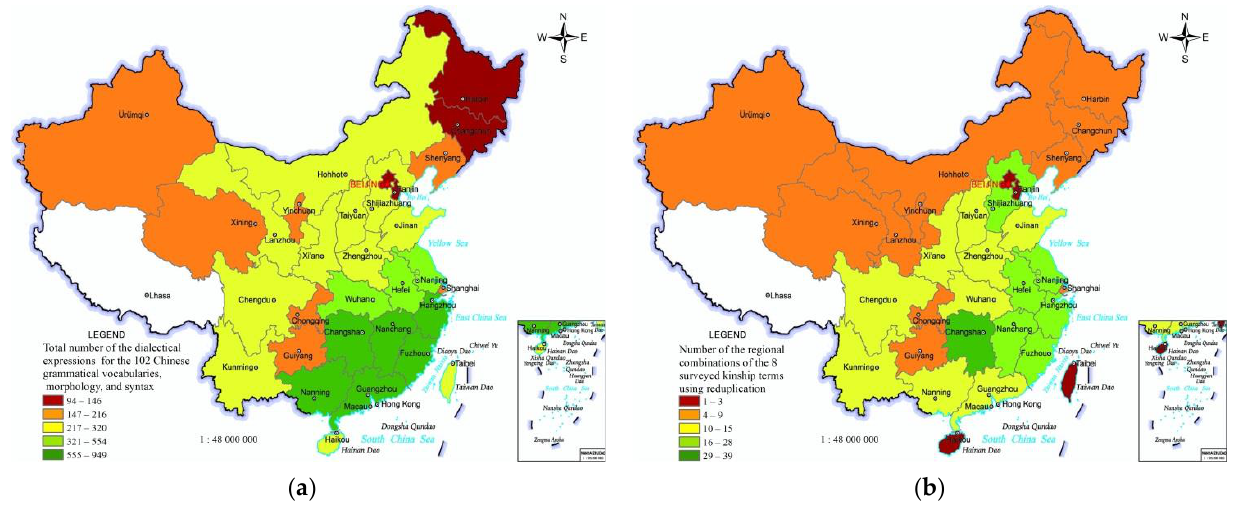
Figure 4. Distribution of grammatical diversity of Chinese dialects. ( a ) Total number of the dialectical expressions for the 102 Chinese grammatical words, morphology, and syntax. ( b ) Number of the regional combinations of the 8 surveyed kinship terms using reduplication.